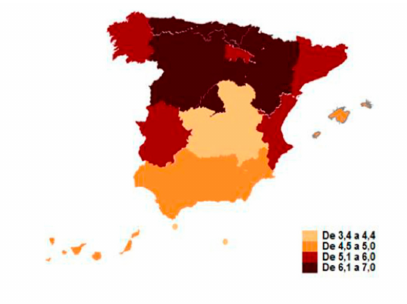
Figure 1. Registered medical professionals in 2019. Quota per 1000 habitants. Source: Instituto Nacional de Estad í stica. 2019